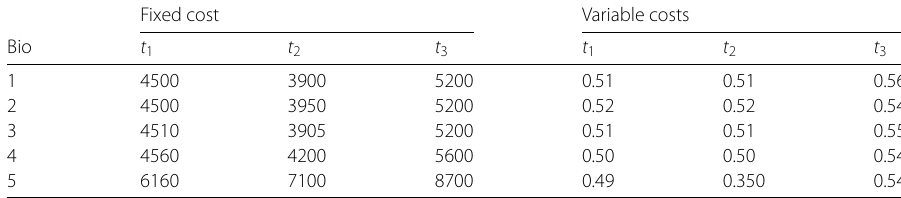
ˇ ξ ∈ jltv , for all t